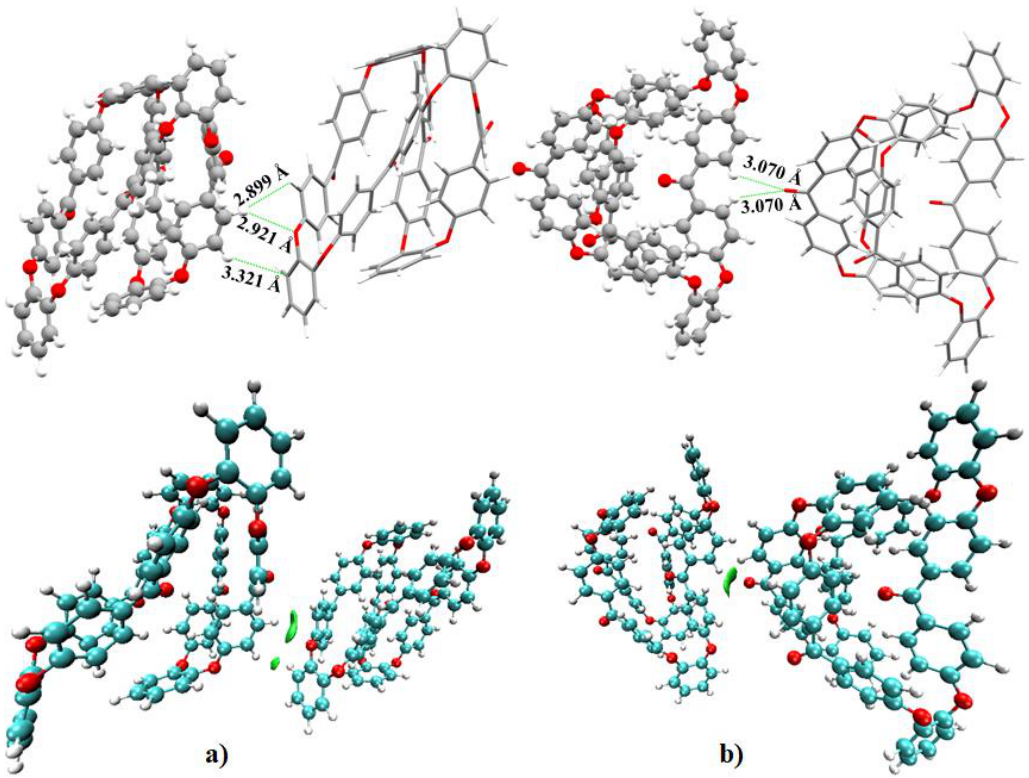
Figure 6. (a )–( b ) (Top) The intermoelcular contact geometries and (Bottom) the IGM isosurface plots (0.005 a.u.) for two randomly selected binary complexes of o-PEEK. Selected intermolecular distances are shown.